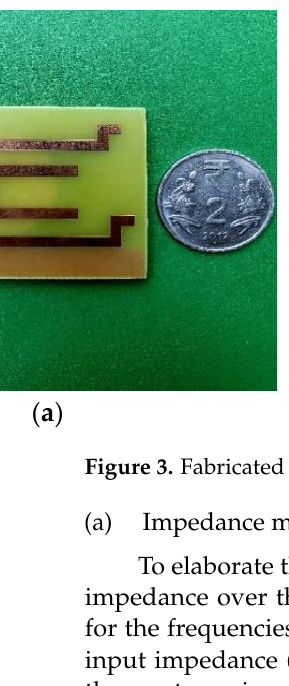
Figure 4. Graph of input impedance vs. frequency. (b)